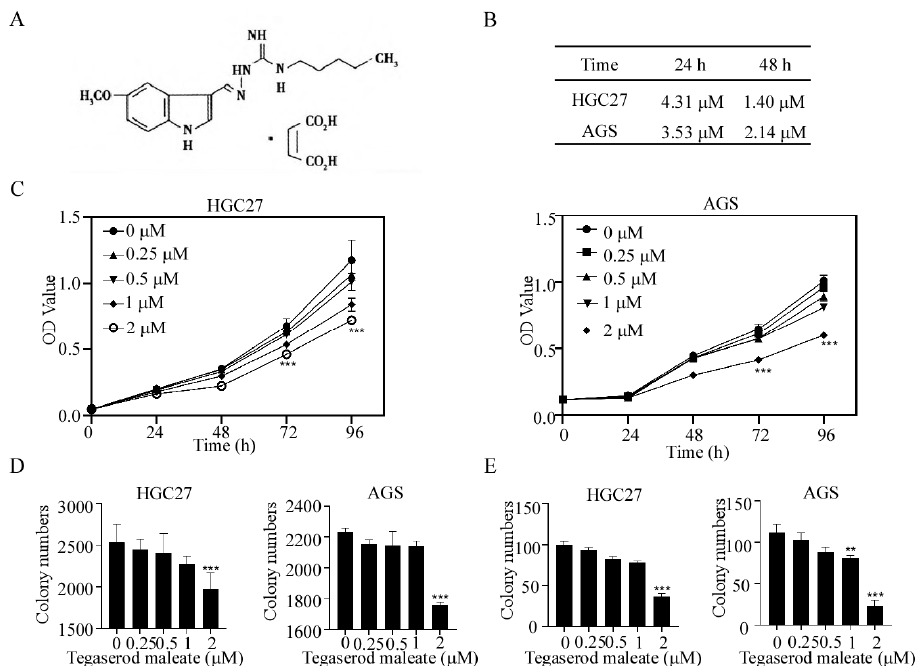
Figure 1. Tegaserod maleate inhibits GC cell proliferation. ( A ) Chemical structure of tegaserod maleate. ( B ) Cell toxicity assay. AGS and HGC27 treated with tegaserod maleate (0, 3.125, 6.25, 12.5, 25, 50 μ M) for 24 and 48 h were evaluated using MTT assay. ( C ) Tegaserod maleate has an inhibitory effect on gastric cancer cells. AGS and HGC27 treated with tegaserod maleate (0, 0.25, 0.5, 1, 2 μ M) for 0, 24, 48, 72 and 96 h were evaluated using MTT assay. ( D ) Tegaserod maleate inhibited anchorage-independent gastric cancer cell growth. AGS and HGC27 cells treated with tegaserod maleate (0, 0.25, 0.5, 1, 2 μ M) for 2 weeks. ( E ) Tegaserod maleate inhibited anchorage-dependent gastric cancer cell growth. AGS and HGC27 cells treated with tegaserod maleate (0, 0.25, 0.5, 1, 2 μ M) for 2 weeks. The asterisks (**) (***) indicate a significant ( p < 0.01 and 0.001).